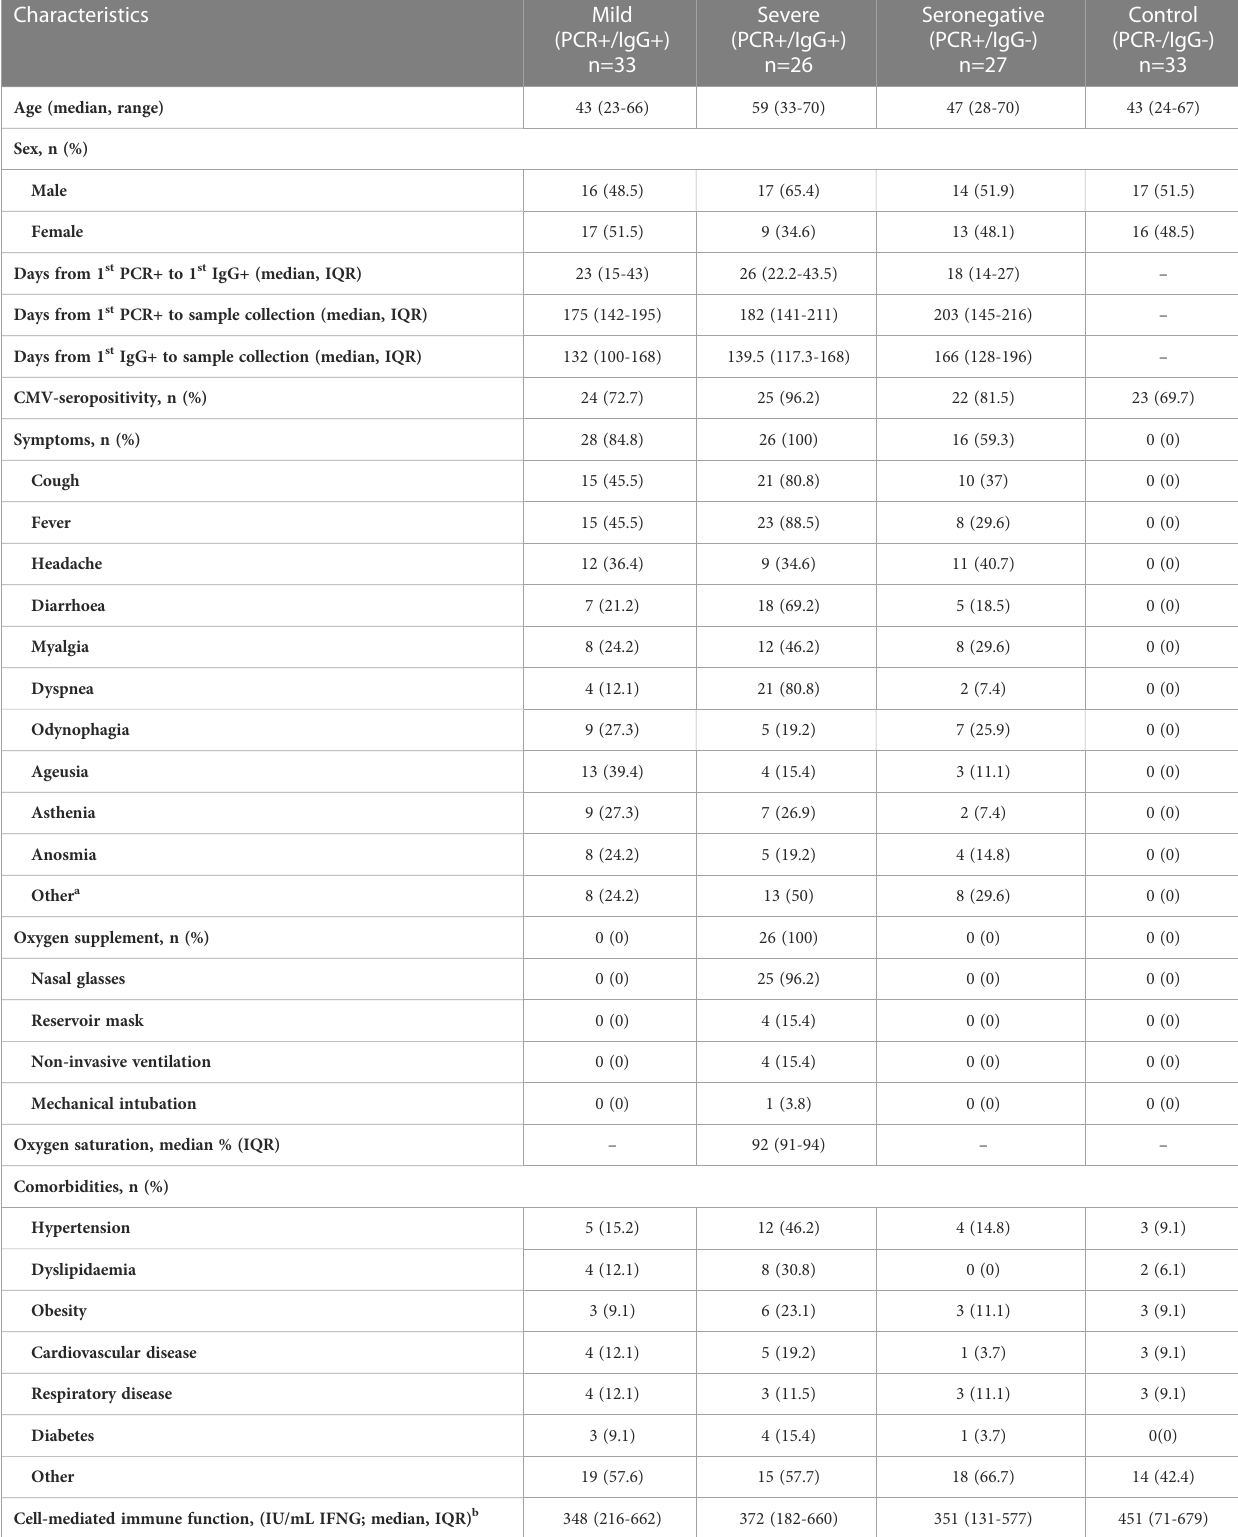
TABLE 1 Demographic and clinical characteristics of the 119 participants.